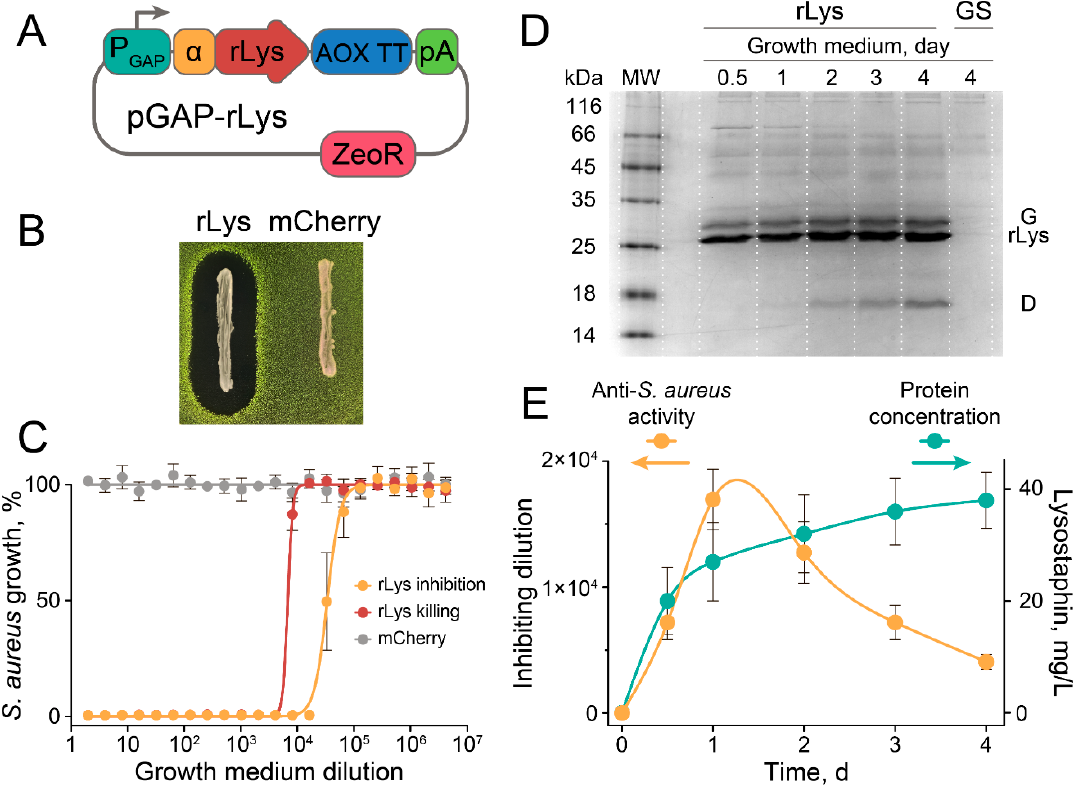
Figure 1. Production of recombinant lysostaphin (rLys) in P. pastoris and its anti- S. aureus activity. ( A ) Schematic representation of vector pGAP α -Lys engineered for heterologous constitutive production of rLys in P. pastoris . P GAP —glyceraldehyde-3-phosphate dehydrogenase (GAP) promoter, α —alpha-factor signal sequence, rLys—codon-optimized sequence of lysostaphin, AOX TT—AOX1 transcriptional terminator, pA—polyadenylation signal, ZeoR—zeocin resistance. ( B ) Agar overlay assay of P. Pastoris GS115 transformed with pGAP α -Lys (rLys) or control vector pGAP α -mCherry (mCherry). GFP-producing S. aureus was used as an indicator strain. ( C ) Inhibition of S. aureus growth by rLys P. pastoris culture medium. S. aureus growth was estimated by the fluorescence of GFP reporter. rLys inhibition (orange) and rLys killing (red) was measured after 1 day and 1 week, respectively. mCherry (gray) indicates the control medium obtained from mCherry-producing P. Pastoris . ( D ) rLys daily production into the growth medium, visualized by 15% PAGE. G—glycosylated rLys; D—a byproduct of rLys proteolytic degradation; GS—parent P. pastoris GS115 strain. rLys production was monitored in rLys P. Pastoris culture supernatant. ( E ) Anti- S. aureus activity in culture medium (orange) and protein production (aquamarine) time curves. Data represent the mean of three biological replicates ± SD.